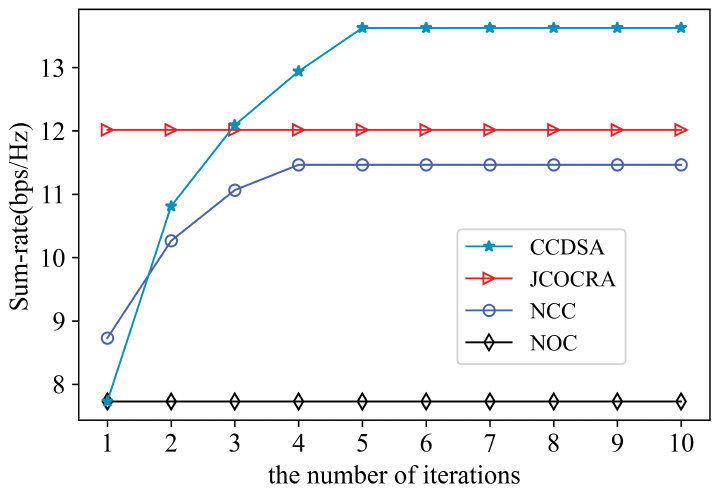
Figure 5. Sum-rate comprison ofdifferent